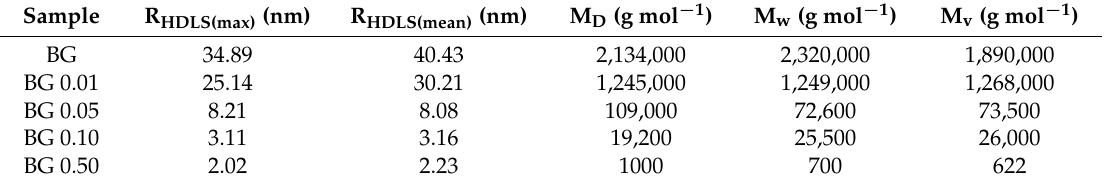
Figure 4. Size distribution of BG and its hydrolysates. Table 5. R HDLS(max) , R HDLS(mean) , and M D for BG and its hydrolysates.